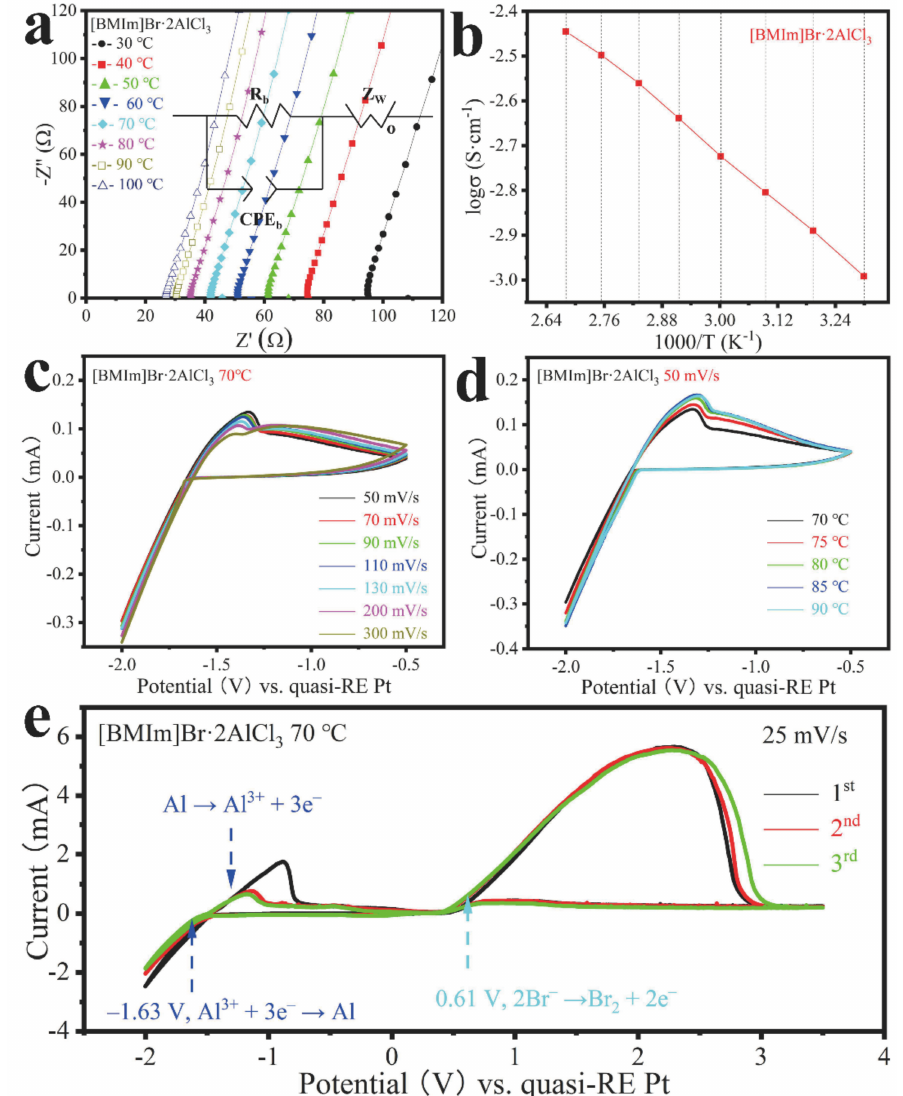
Figure 1. Electrochemical properties of [BMIm]Br · 2AlCl 3 . ( a ) Magnified EIS. (inset: the equivalent circuit for simulation). ( b ) Temperature dependence of the ionic conductivity. ( c ) CV at 70 ◦ C and different scan rates. ( d ) CV at a scan rate of 50 mV s − 1 and different temperatures. ( e ) CV at 70 ◦ C and 25 mV s − 1 (firstly scanning toward the negative